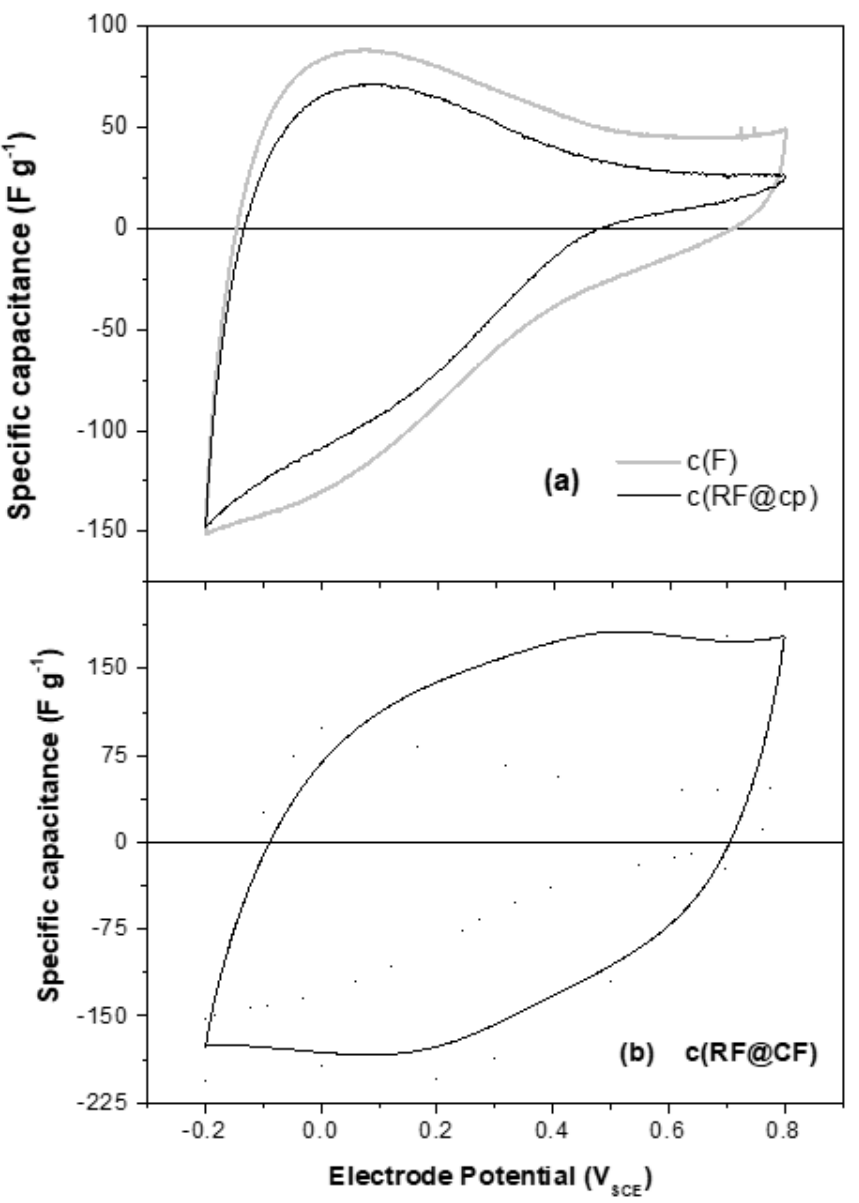
Figure 8. Cyclic voltammograms of ( a ) a carbonized RF resin deposited on a thin film of regenerated cellulose (c(RF@cp), black line) and a carbonized cellulose fiber fabric (c(F), grey line), and ( b ) a carbonized RF resin deposited onto carbonized cellulose fabric (c(RF@c(F)). Scan rate = 1 mVs − 1 . Solution = 1 M H 2 SO 4 .